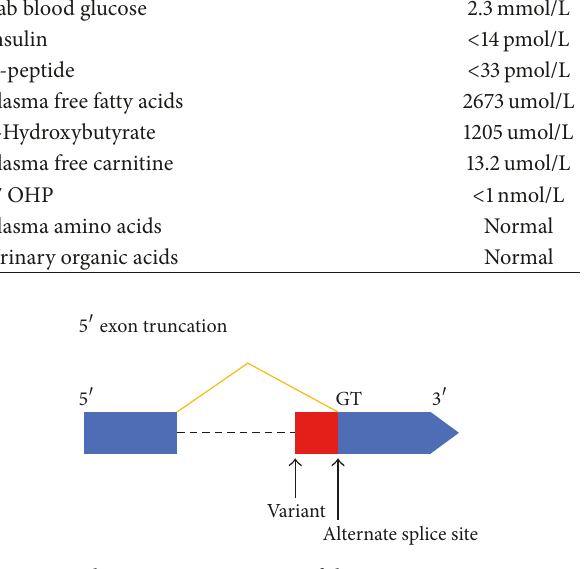
Figure 2: Schematic representation of the exon-intron structure in B3GAT3 depicting the position of the splice site variant and the GT splice donor site. The variant results in the creation of an alternative splice